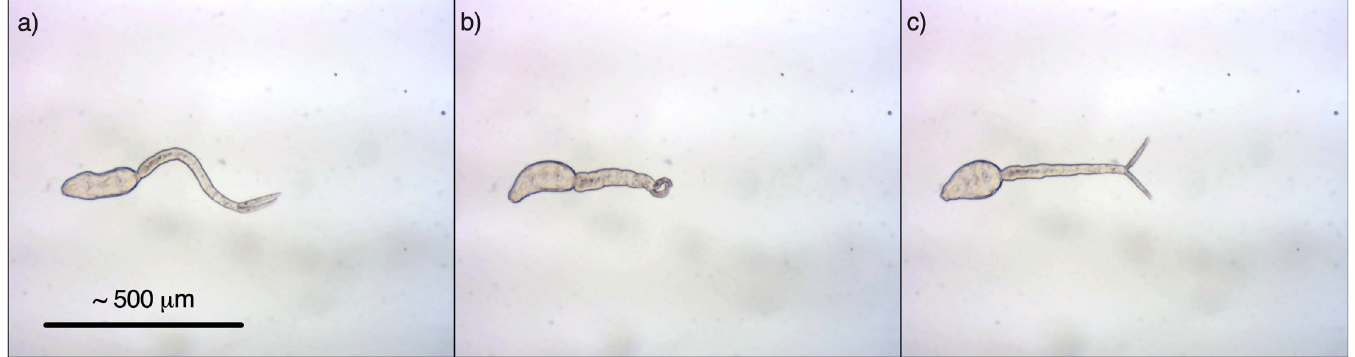
Fig 2. Series of photos showing tail thrusting and stretching and contraction of a S . mansoni cercaria from a control sample (0 mJ/cm 2 ), 40 × magnification.